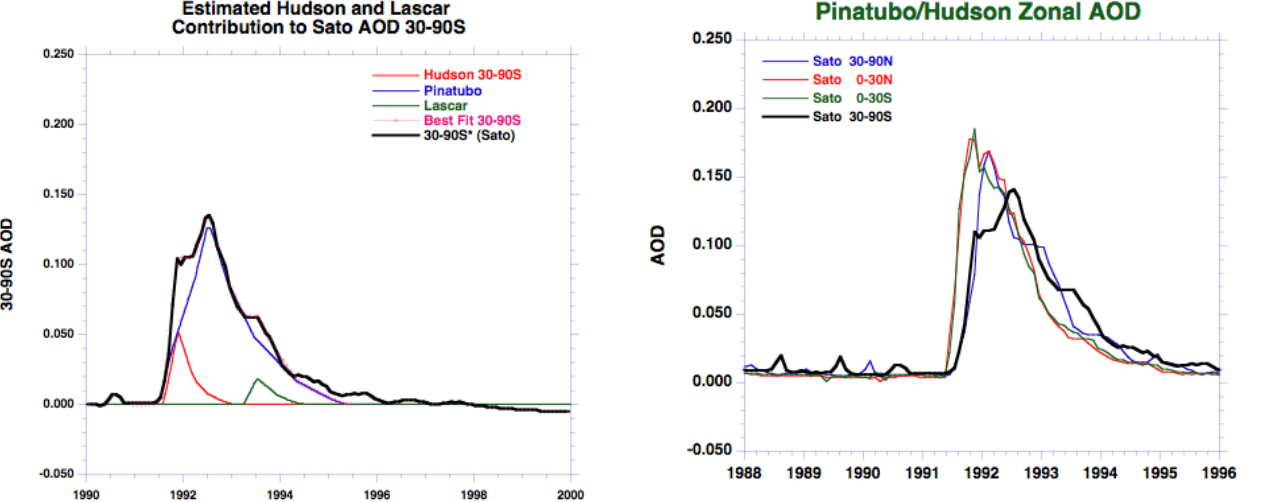
Figure 1. Best fit iteration of contribution of smaller Southern Hemisphere eruptions to the zonal mean 30–90 ◦ S values of Sato et al. (1993).